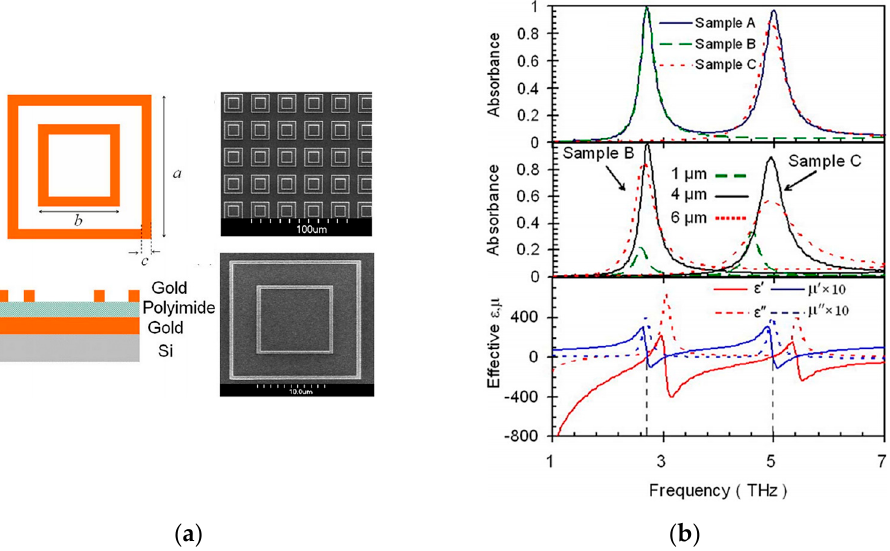
Figure 10. ( a ) Structure and SEM of the terahertz dual − band metamaterial absorber; ( b ) absorption curves and calculated effective dielectric constant and permeability under different structural parameters [48] .